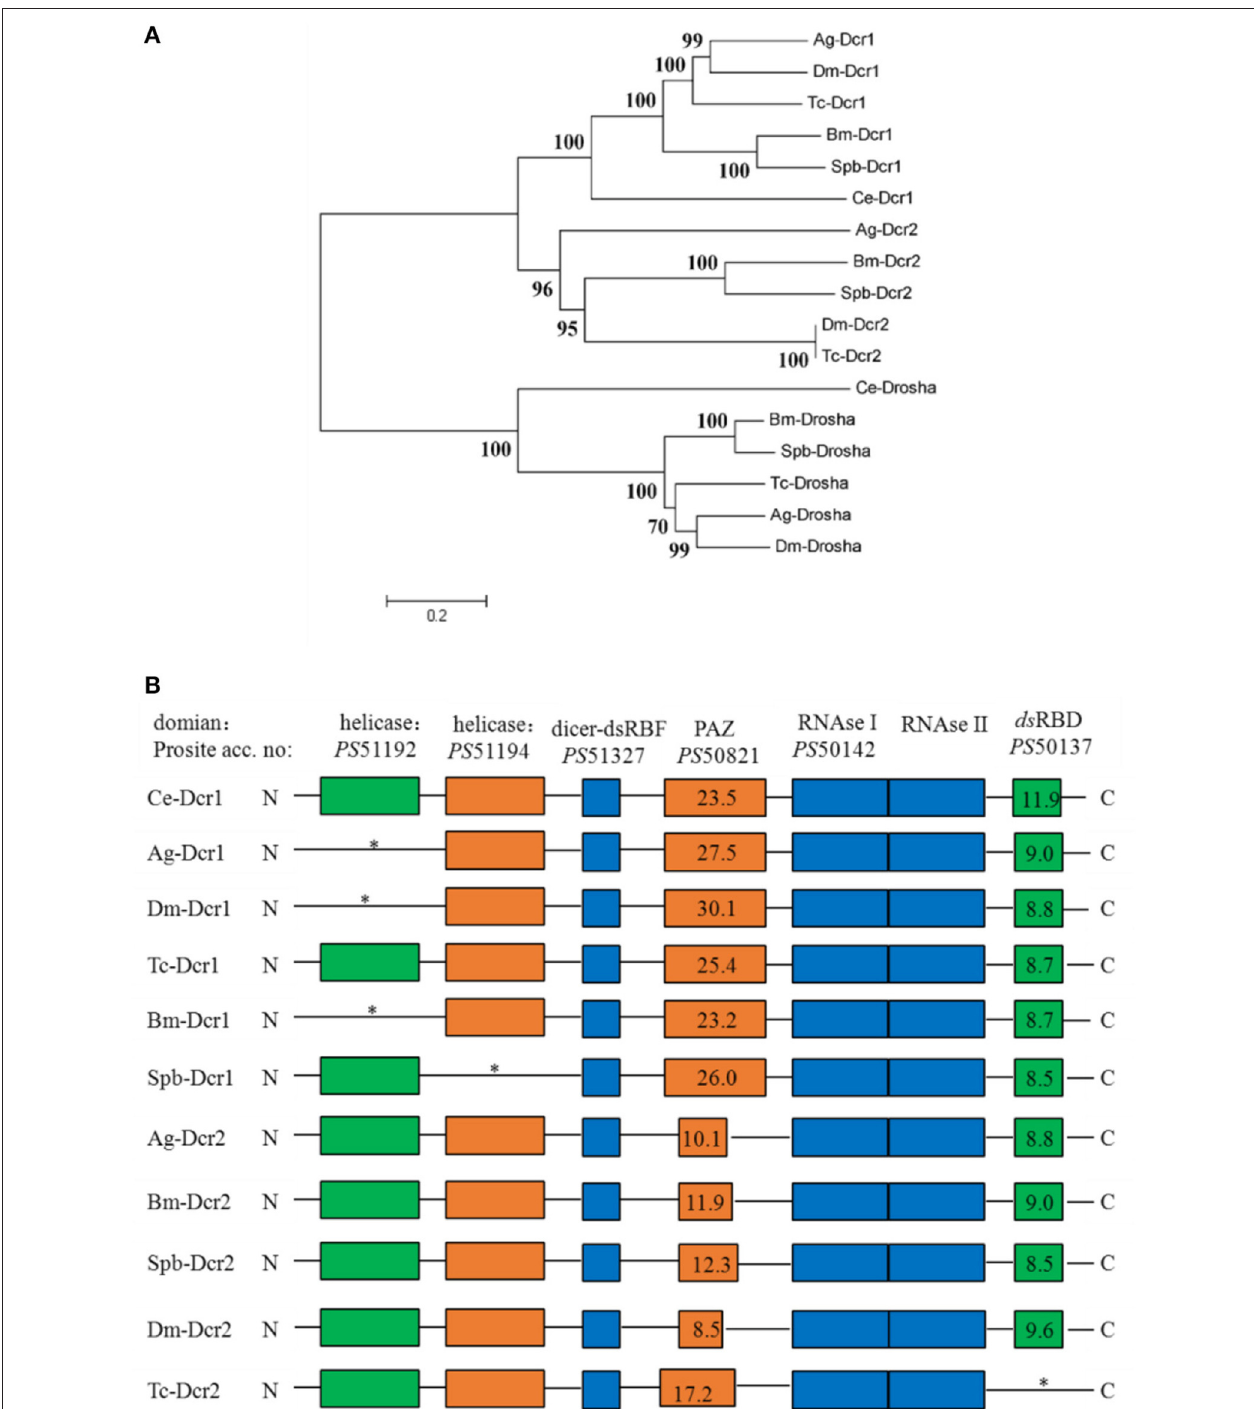
FIGURE 4 | Phylogenetic and domain architecture analysis of Dicer proteins. (A) Neighbor-joining inferred phylogenetic relationships among insect Dicer proteins, including CeDcr-1 (NP_498761), AgDcr-1 (AAO73809), DmDcr-1 (NP_524453), BmDcr-1 (XP_004922366), TcDcr-1 (EFA11550), SpbDcr-1 (c79781), AgDcr-2 (XP_320248), BmDcr-2 (NP_001180543), SpbDcr-2 (c79492), DmDcr-2 (NP_23778.2), TcDcr-2 (NP_001107840), CeDrosha (O01326), AgDrosha (XP_555381), BmDrosha (XP_004928266), TcDrosha (XP_008199088), SpbDrosha (c79402). Bootstrap values (1,000 replicates) are shown next to the branches. (B) Domain architecture of Dicer proteins. Conserved domains and their ScanProsite profile hit scores are indicated. Ce, Caenorhabditis elegans , Bm, Bombyx mori ; Dm, Drosophila melanogaster ; Tc, Tribolium castaneum ; Ag, Anopheles gambiae ; SPb, soybean pod borer.